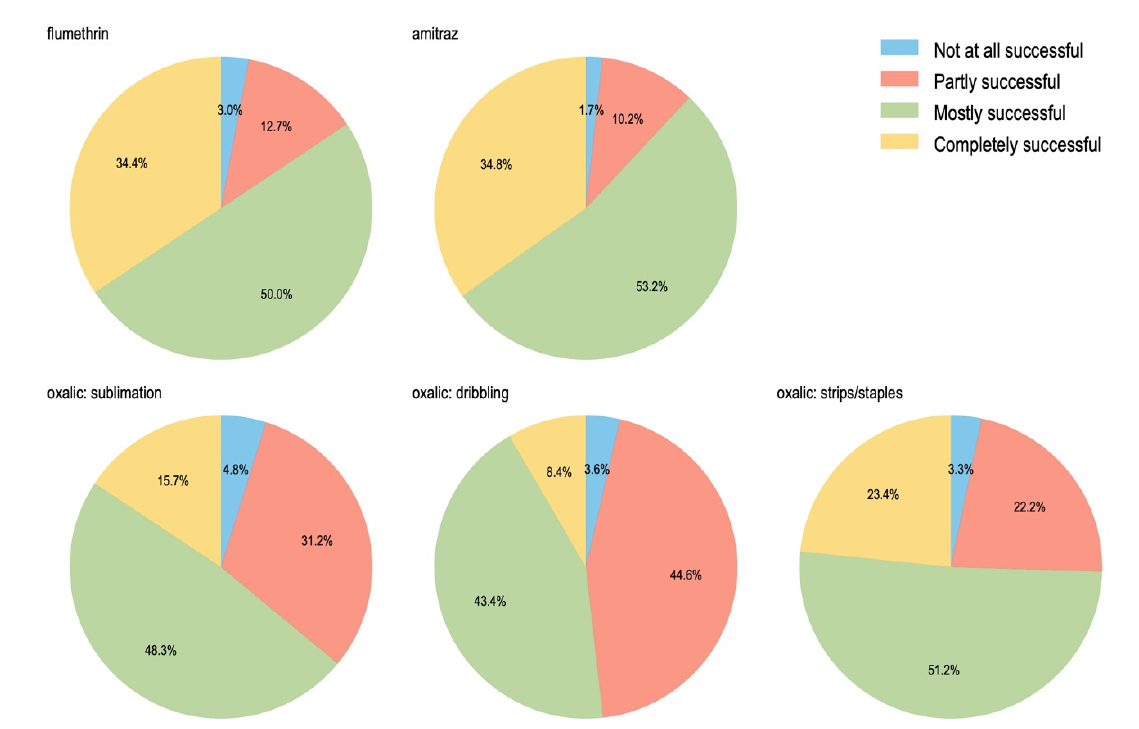
Figure 5. Beekeepers’ self ‐ reported effectiveness of varroacides in managing varroa infestation, rated as having been completely successful, mostly successful, partly successful or not at all successful during the winter of 2021. The most common varroacide treatments in New Zealand are flumethrin, amitraz, and oxalic acid. Oxalic acid was divided into sub ‐ categories, based on the three most common methods of application: sublimation, dribbling, or the in ‐ hive placement of strips/staples that have been soaked in oxalic acid.